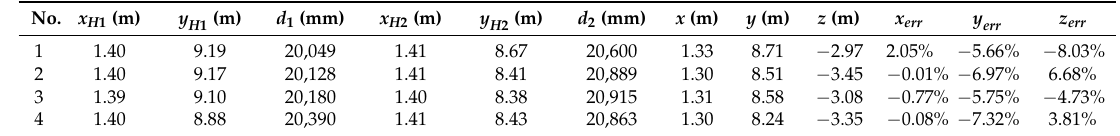
Table 1. Data acquired from this experiment. ( x H 1 , y H 1 ) and ( x H 2 , y H 2 ) are the target’s coordinates extracted from the two sonar images acquired at different positions; d 1 and d 2 are the locations of carriage 1; ( x , y , z ) are the 3D coordinates of the target calculated with the proposed method, and ( x err , y err , z err ) are the errors of ( x , y , z ) compared with ( 1.30, y meas , − 3.23 ) .